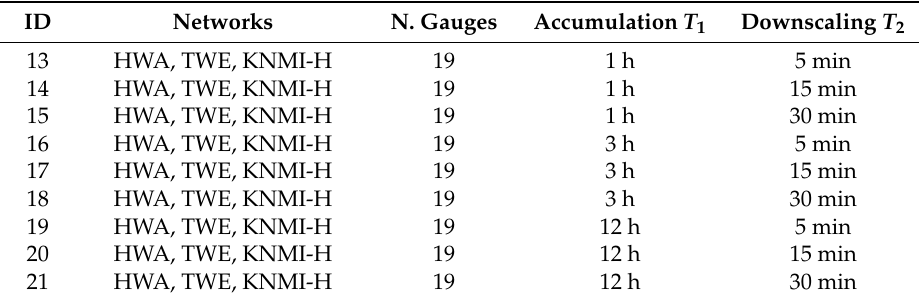
Table 3. Different sub-daily accumulations and downscaling intervals are tested with the available rain gauges at sub-daily resolution in the Dutch case study.